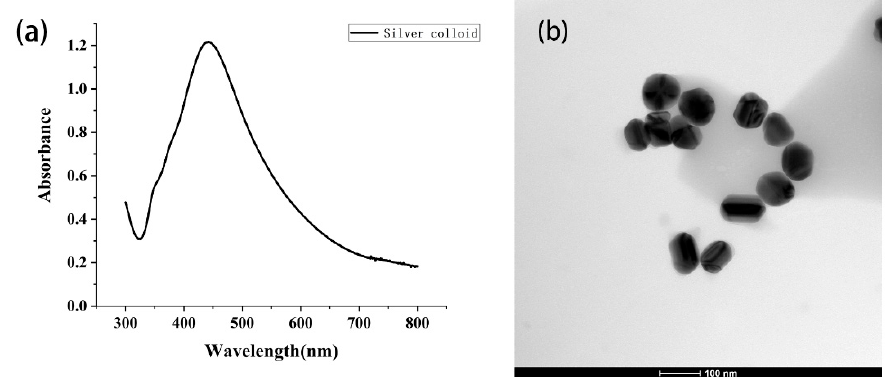
Figure 1. ( a ) The UV–vis absorption spectrum of the surface-enhanced Raman spectroscopy (SERS) substrate, ( b ) the TEM image of silver nanoparticles.